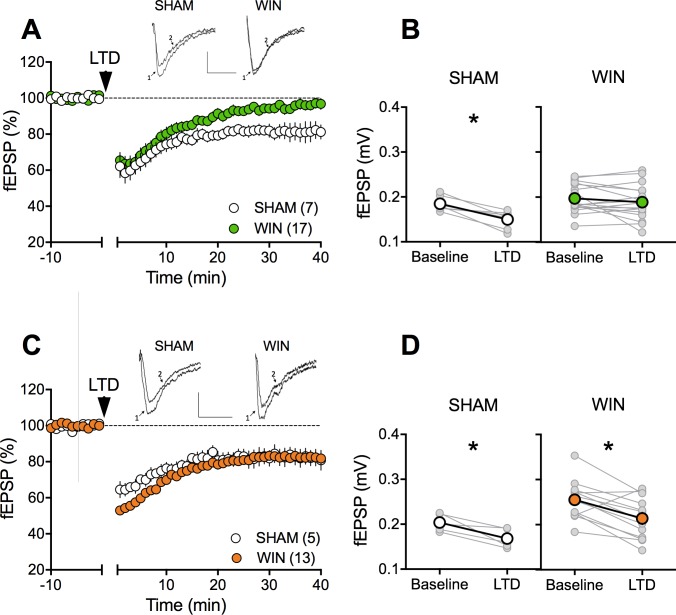
Sexual divergent ablation of LTD in the PFC of adult rats prenatally exposed to WIN.(A) Average time-courses of mea field EPSPs showing that low-frequency stimulation (10 min at 10 Hz, arrow) induced LTD of evoked fEPSPs recorded in the mPFC in SHAM (n = 7; white circles), but not in WIN (n = 17; green circles) prenatally-exposed male rats. Above: example traces, baseline (1) and 40 min post-stimulation (2). (B) Individual experiments (grey) and group average (white represents SHAM; green represents WIN), before (baseline) and after (40 min) LTD induction showing the lack of LTD in the WIN exposed group. In SHAM rats: 0.185 ± 0.006 mV before LTD versus 0.150 ± 0.007 mV after LTD induction (n = 7, p<0.05, paired t-test). In WIN animals: 0.197 ± 0.008 mV before LTD versus 0.189 ± 0.009 mV after LTD induction (n = 17, p>0.05, paired t-test). (C) Average time-courses of mean EPSPs showing similar low-frequency LTD in SHAM (n = 5; white circles) and WIN (n = 13; orange circles) in utero-exposed female rats. Above: example traces, baseline (1) and 40 min post-stimulation (2). (D) Individual experiments (grey) and group average (white represents SHAM; orange represents WIN), before (baseline) and after (40 min) LTD induction showing that prenatal WIN exposure does not alter LTD in the female exposed group. In SHAM female rats: 0.204 ± 0.009 mV before LTD versus 0.168 ± 0.010 mV after LTD induction (n = 5, p<0.05, paired t-test). In WIN female rats: 0.255 ± 0.012 mV before LTD versus 0.214 ± 0.013 mV after LTD induction (n = 13, p<0.05, paired t-test). *p<0.05. n = individual rats. Error bars indicate SEM. Scale bar: 10 ms, 0.1 mV.